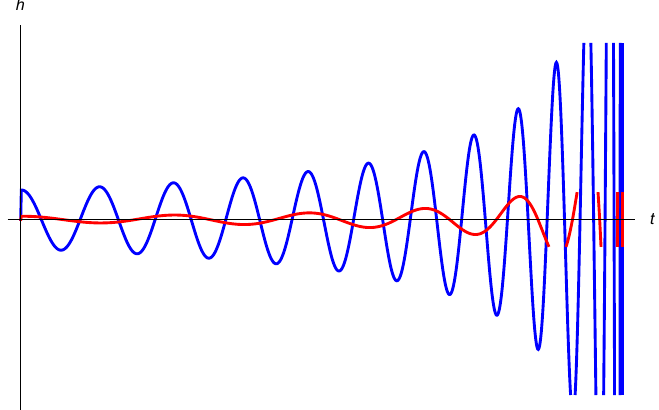
Figure 12 . Waveform for h + (blue) and due to the parity violating effects, h × (red). For compact objects of similar masses and k EB the order of 2